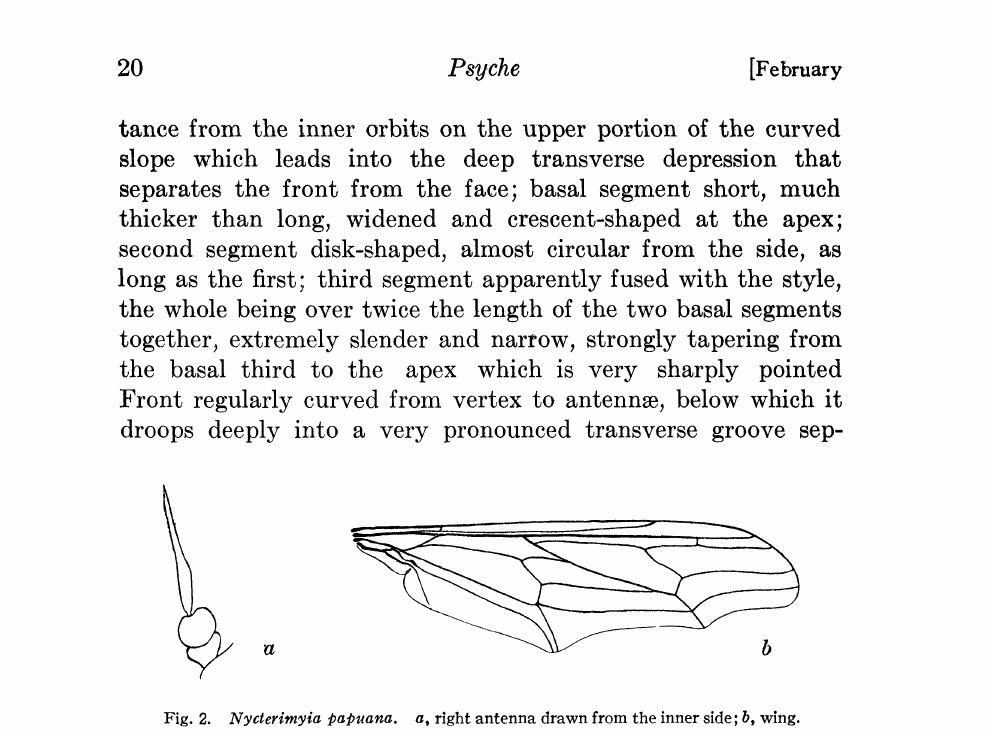
Fig. 2. Nyeterimyia papuana, a, right antenna drawn from the inner side; b, wing. arating the